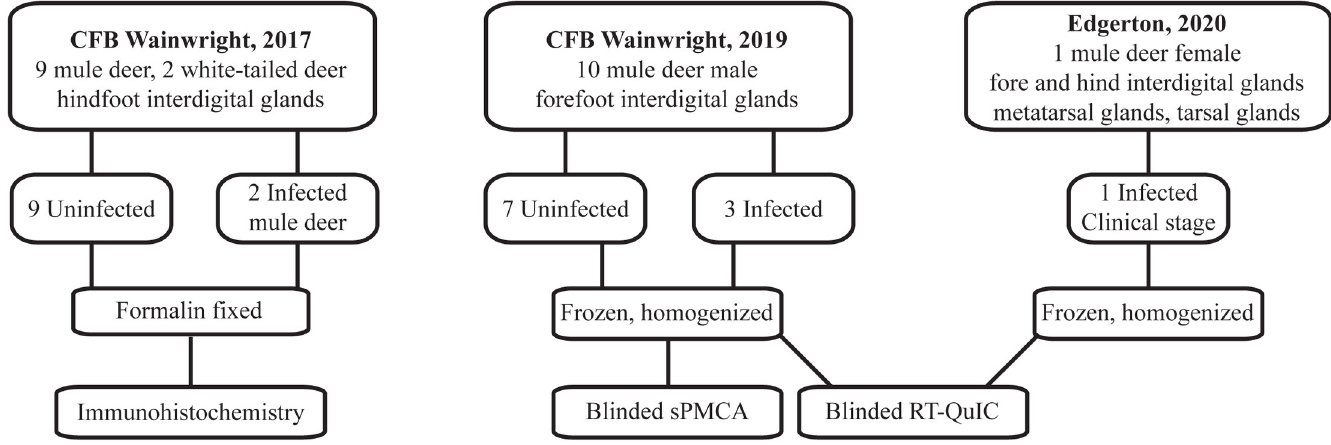
Fig 1. Conceptual diagram of sample origin and